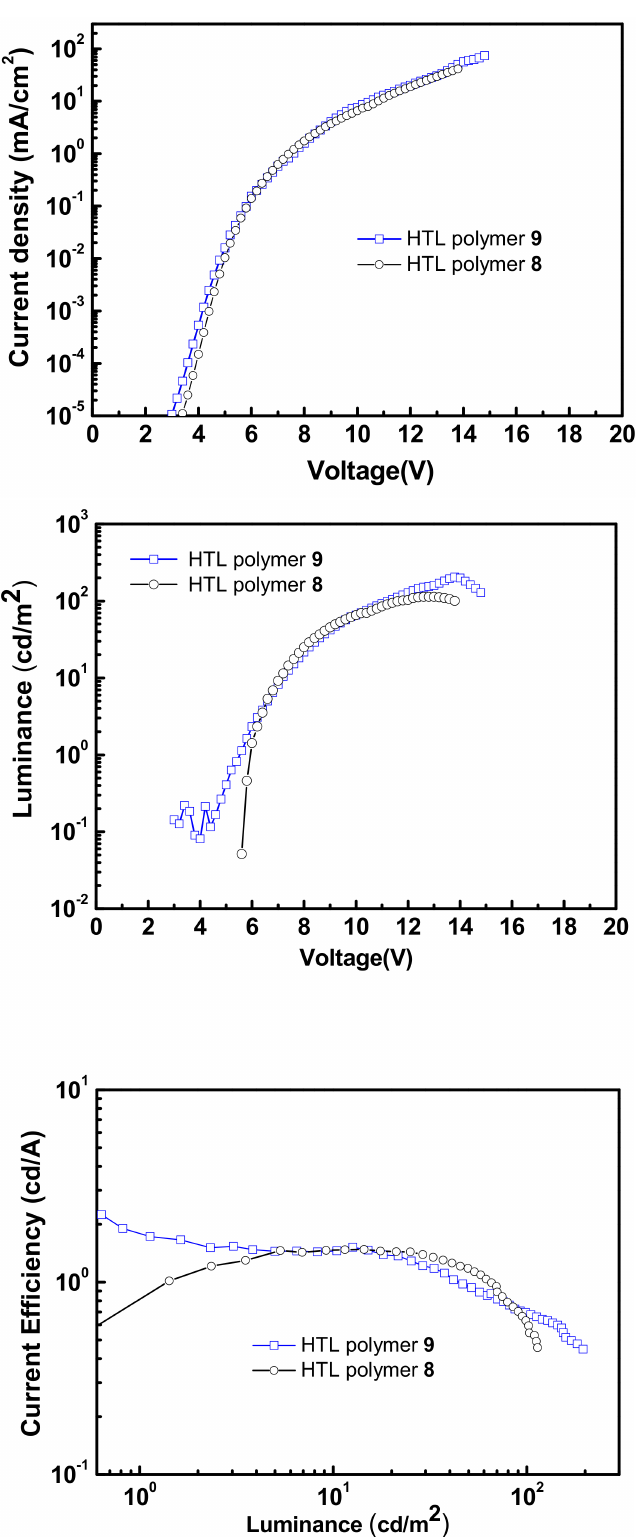
Figure 4. Organic light-emitting diode (OLED) characteristics of the devices with the configuration: ITO/ 8 or 9 /Alq 3